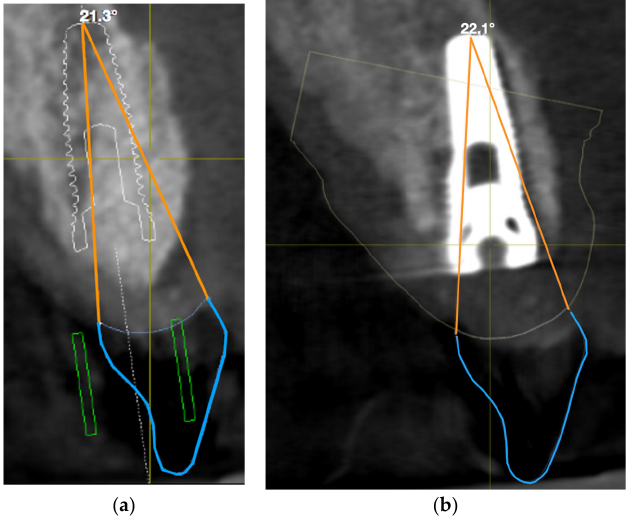
Figure 1. Comparison of implant axis on CBCT scans performed before and after implant surgery to verify congruence of implant placement (in orange). In blue, virtual wax ‐ up of the future fixed crown. ( a ) Implant position in preoperative digital planning; ( b ) Implant position after computer ‐ guided surgical insertion.